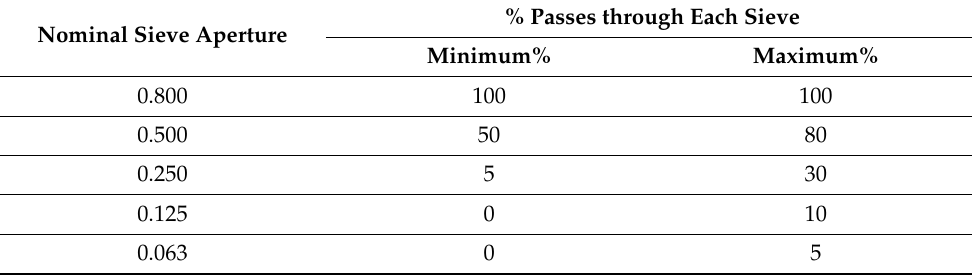
Table 3. Granulometric analysis of the powdered rubber